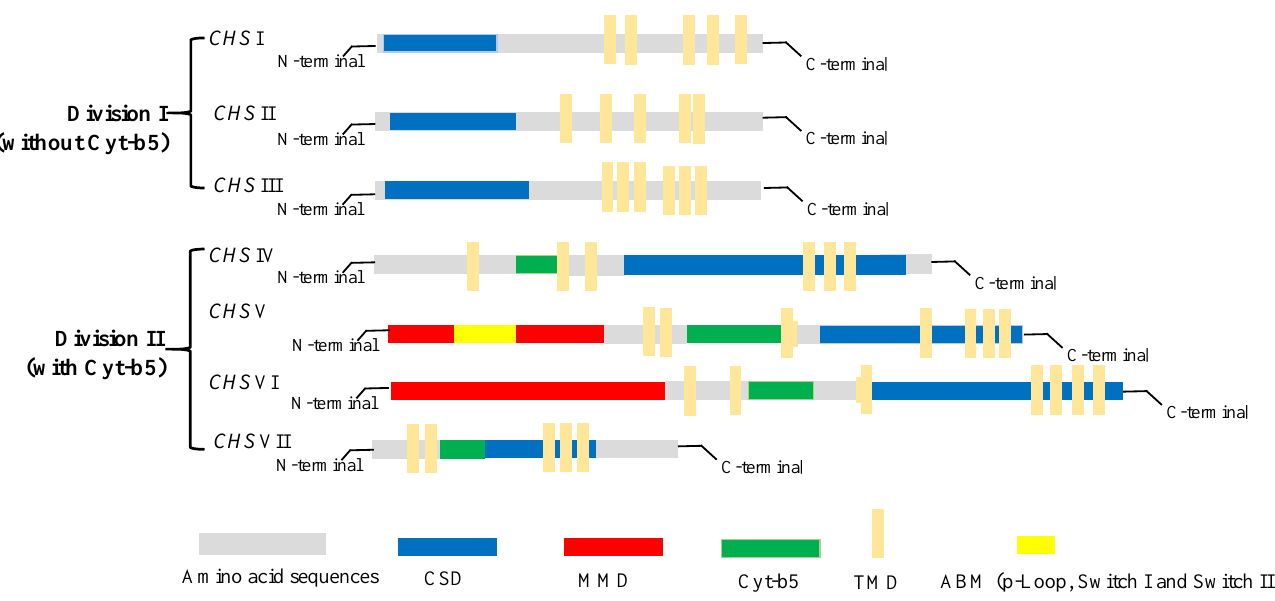
Figure 4. The structure and classification of members of the chitin synthase family.